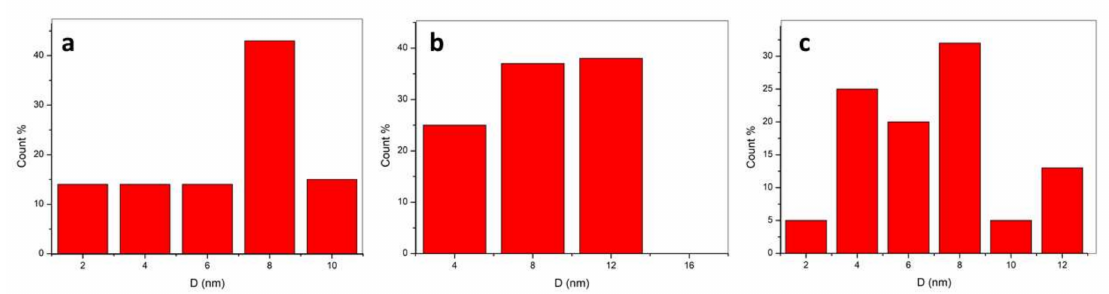
Figure 10. Particle size distribution of Ni/MgAl 2 O 4 sulfided with (NH 4 ) 2 S (S2) at ( a ) 200 ◦ C, ( b ) 400 ◦ C, and ( c ) 550 ◦ C.